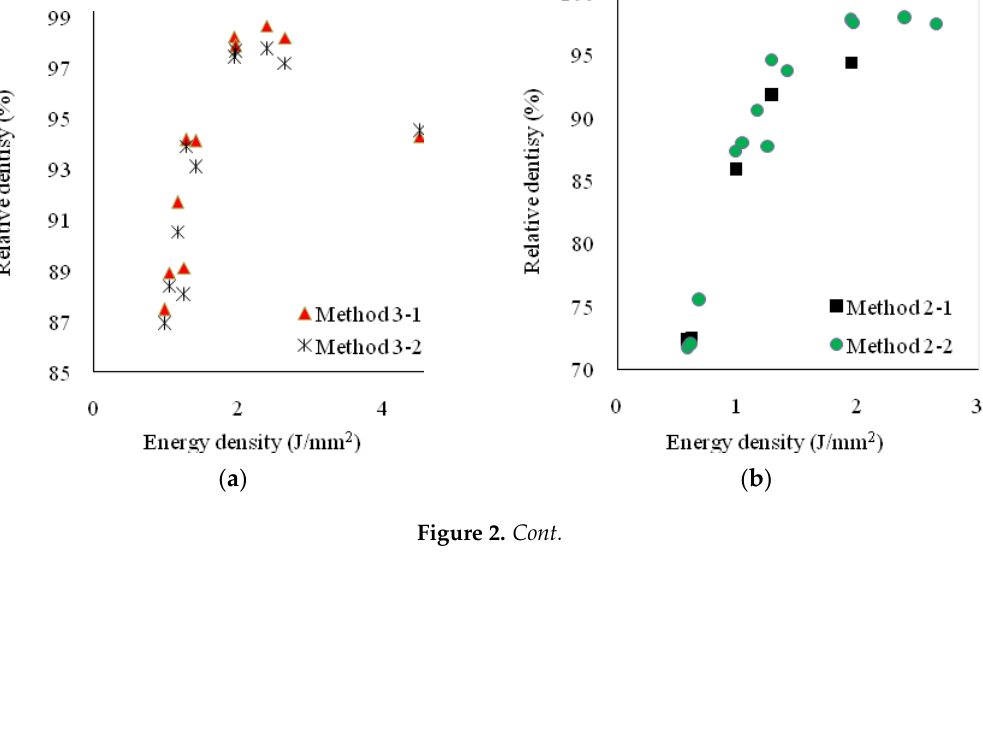
( d ) Figure 2. Comparison of results of relative density using different methods: ( a ) comparison of method 2-1and method 2-2; ( b ) comparison of method 3-1, method 3-2; ( c ) comparison of method 2-2, method 3-2 and method 4; and ( d ) comparison of method 1, method 4, and image analysis. 3.1.1. Archimedes Method Figure 2a shows the comparison between results using method 2-1 and method 2-2, respectively, for the samples with SLMed surface and with ground surface. From Figure 2a, it can be seen that the ground samples have a higher density than the ones with SLMed surfaces. This is because more liquid remains on the rough surface of the SLMed AlSi10Mg samples when measuring the mass of liquid-impregnated samples. According to Equation (3), if the mass m wet is higher than the actual value, the density is lower than the actual one. Therefore, when considering the effect of the open cavities on the density measurement, it is necessary to grind the surfaces of samples to avoid excessive residual liquid left on the surface of samples. Figure 2b gives the comparison of method 3-1 and method 3-2, which kept the test samples immersed in liquid (tetrachloroethylene) for 5 min and 30 min, respectively, for liquid-impregnation in a vacuum environment. Figure 2b shows that the density results of the liquid-impregnation of 5 min are higher than those of 30 min for almost all samples. This indicates that a sufficient amount of